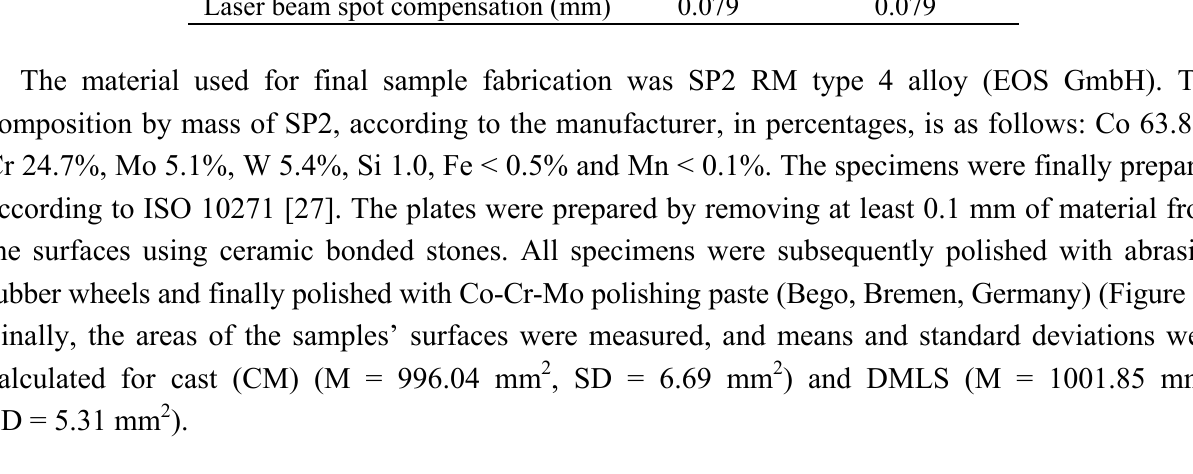
Figure 2. DMLS specimen: ( a ) before polishing; ( b ) after